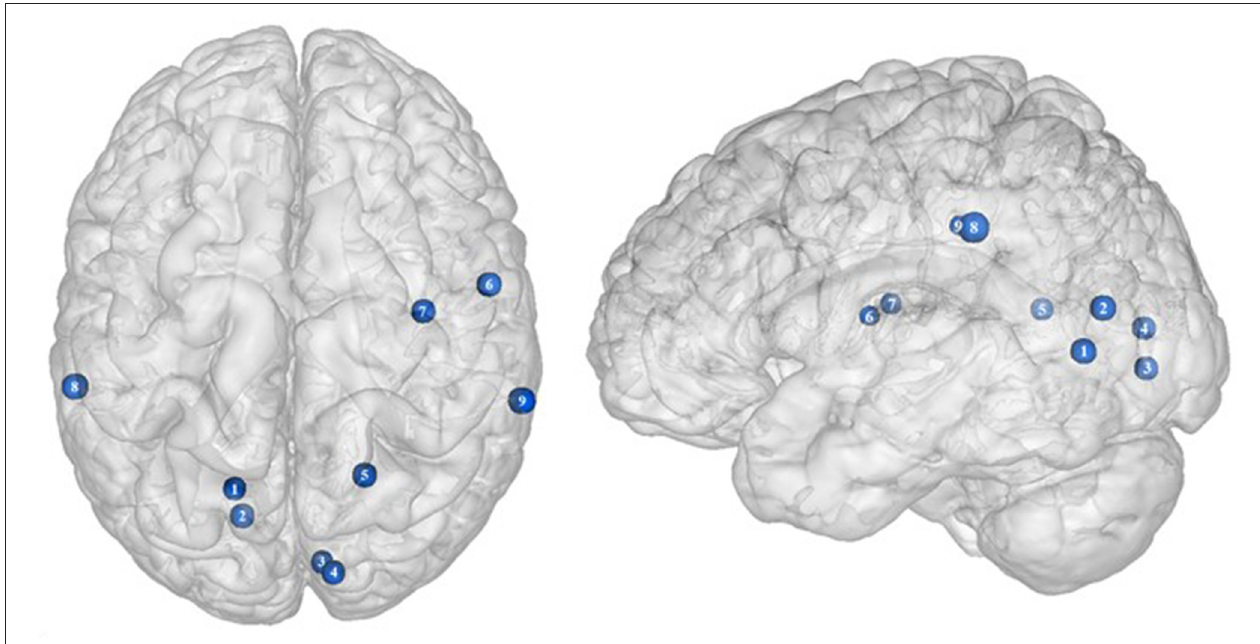
FIGURE 4 | Functional activity in other regions during inhibition. Blue color indicates hypoactivity in obese in comparison with lean individuals during inhibition (see Table 4 for precise coordinates). 1–5 = visual cortex ( 48), 6–7 = rolandic operculum (49), 8–9 = inferior parietal cortex (48).